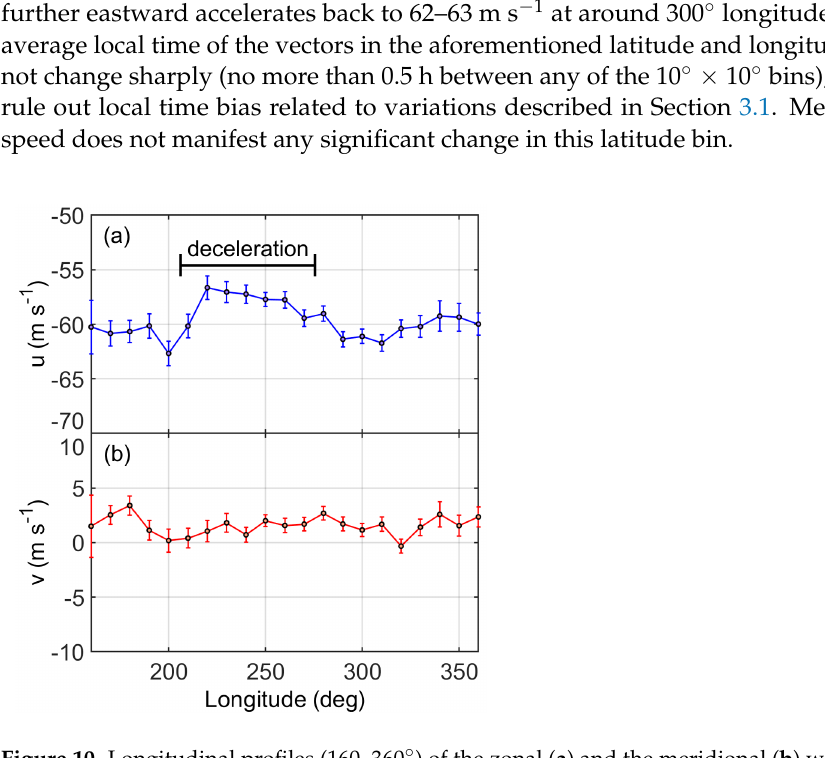
Figure 10. Longitudinal profiles (160–360°) of the zonal ( a ) and the meridional ( b ) wind speed in the 40°–50° S latitude bin. Error bars show standard error for a 99% confidence interval.